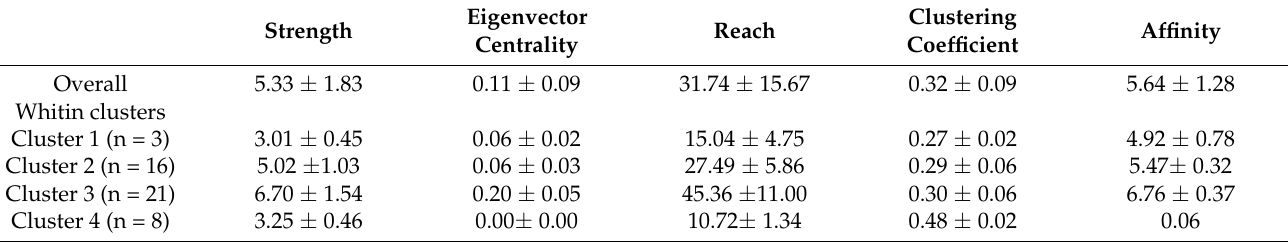
Figure 8. Social network diagram. Nodes represent different individuals, each node is characterized by a different color linked to the cluster division (purple for cluster 1, red for cluster 2, green for cluster 3, light blue for cluster 4), by a different size, proportional to its strength value, and by a different shape, related to the site fidelity group division: circular for transient, square for resident, triangular for visitor. Table 6. Mean values of strength, eigenvector centrality, reach, clustering coefficient and affinity resulting from the social network analysis and considering all 48 individuals included in the analysis (overall values) and individuals in each cluster (within cluster values).